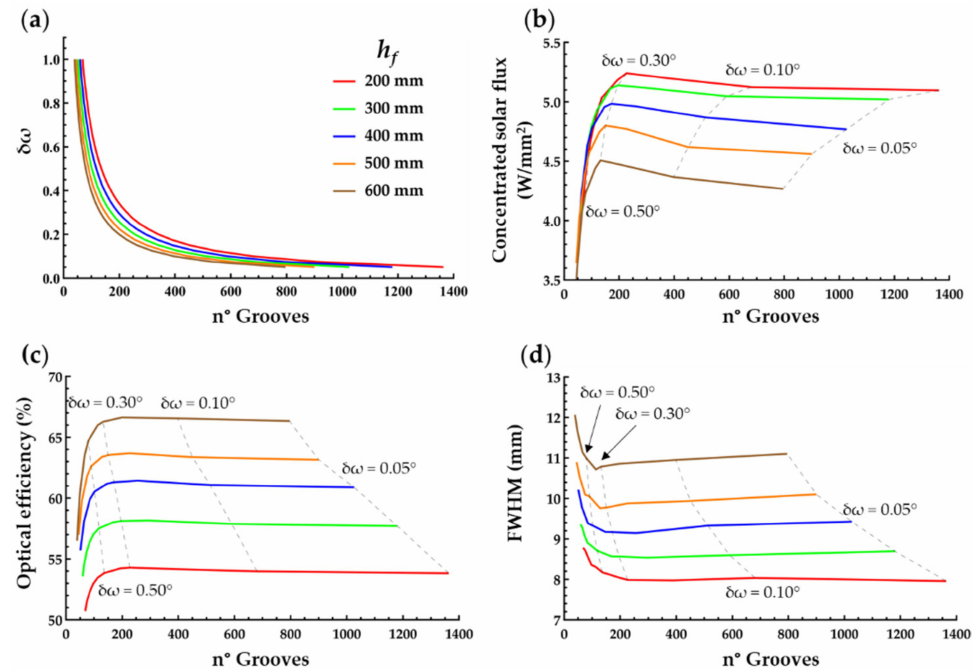
Figure 16. Characteristic of the Gaussian distribution source at the focal zone: ( a ) δω , ( b ) concentrated solar flux, ( c ) optical efficiency and ( d ) FWHM as a function of the number of